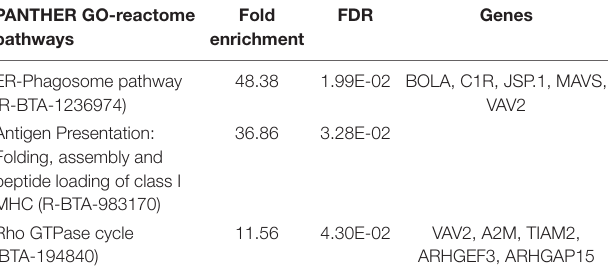
group ( Figure 5B ). While HERPUD1 expression in the RNAseq data was significantly lower in the “SF” group than the “SC” group, RT-qPCR showed no difference between these groups ( Figure 5E ). The tendency of HERPUD1 expression in RNAseq data to be lower in “SF + PGE2” group than the “SC” group was also found in RT-qPCR data ( P = 0.122) ( Figure 5E